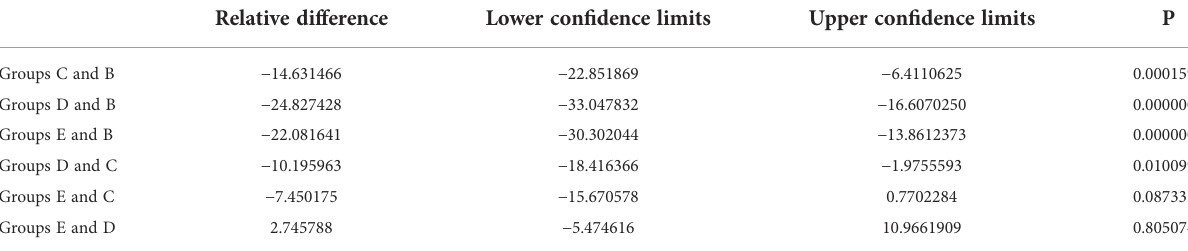
(Table 11). Further pairwise comparisons were performed, and Tukey ’ s method was used to adjust the multiplicity. The results showed no signi fi cant difference between groups D and E, while